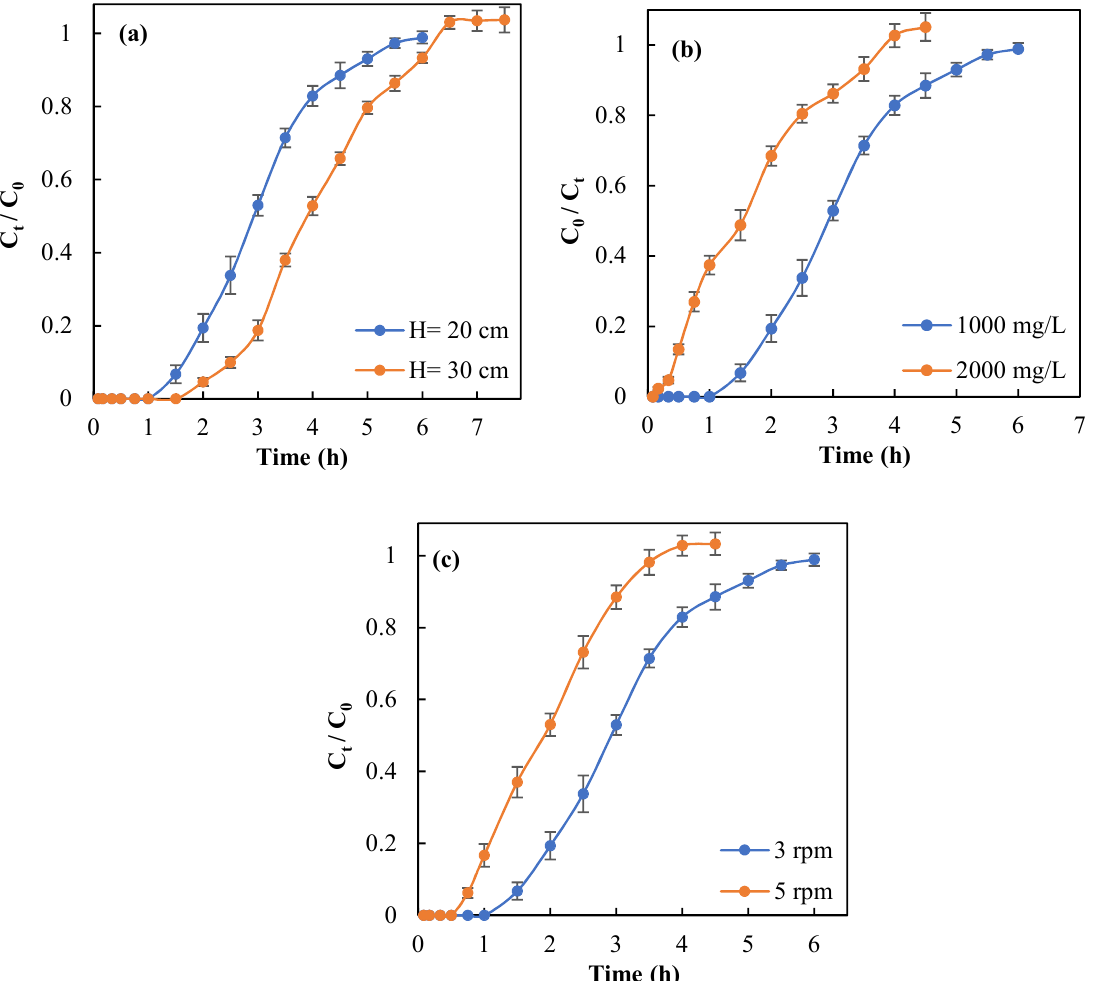
Figure 7. Breakthrough curves for sulfate adsorption onto the Ca–CP adsorbent at different operating conditions: ( a ) bed height, ( b ) initial sulfate concentration, and ( c ) flow rate. Table 4. Breakthrough curve parameters for sulfate uptake by Ca–CP at variable conditions.